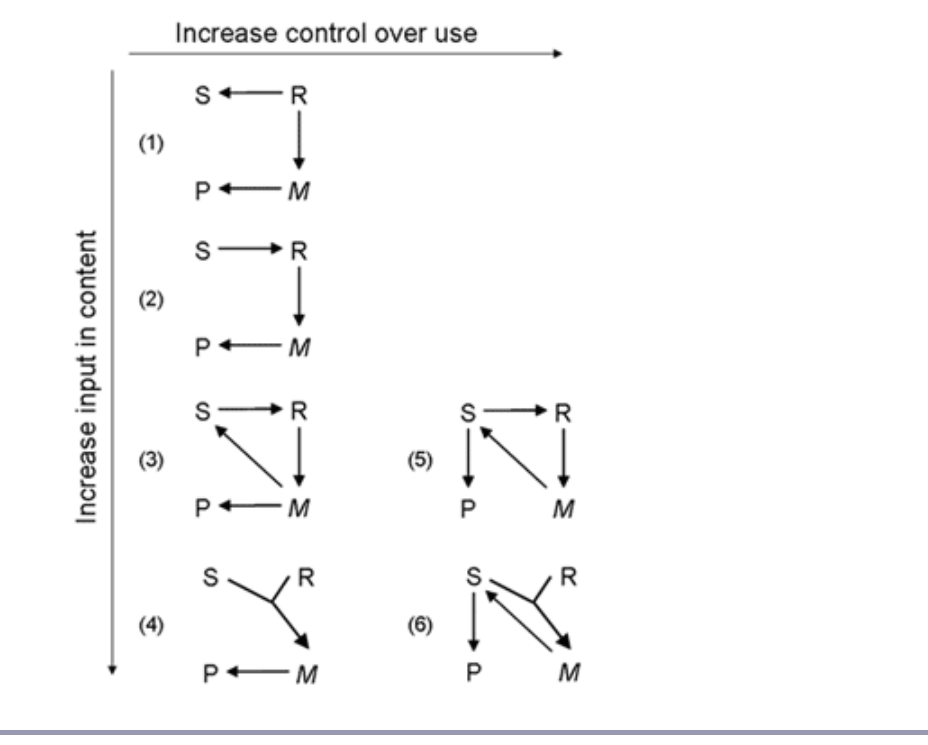
Fig. 4. Categories of participatory research process according to flows of